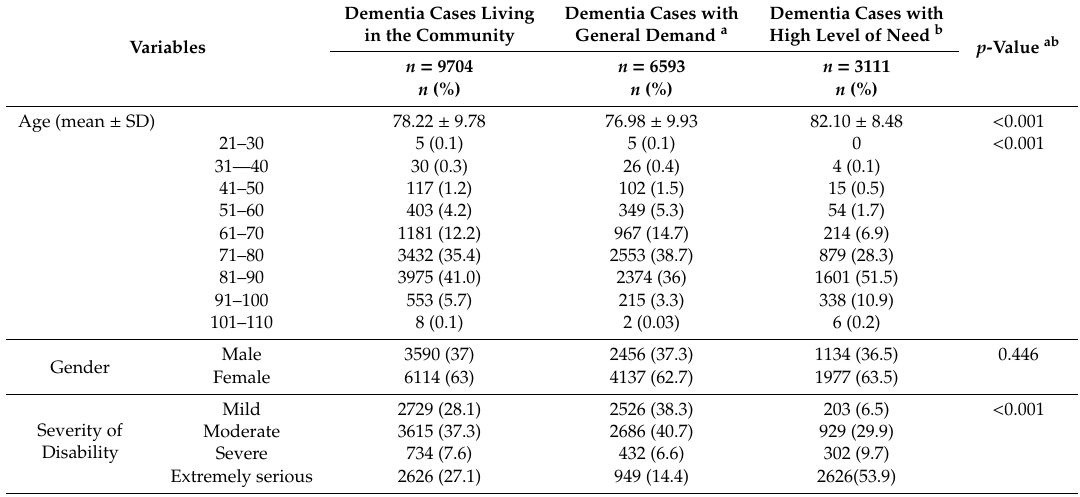
Table 1. Demographic characteristics of dementia cases in the current study. Dementia Cases Living in the Community Variables